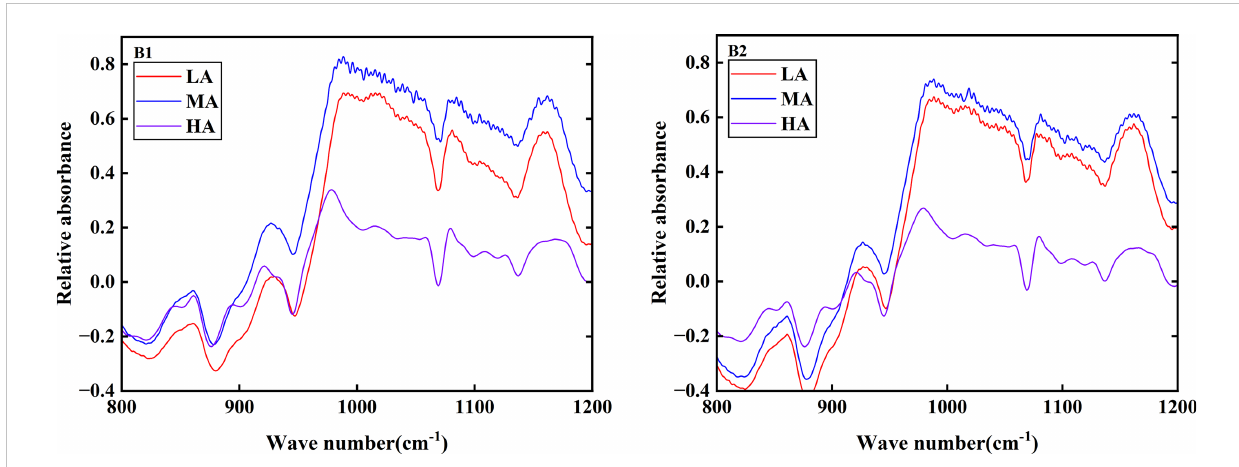
Figure 10 (DSC endothermic curve) of the thermal gelatinization characteristics of two potato starch varieties showed that in Xichang, the temperature span of Jiusen No.1 and Qingshu No.9 for gelatinization is longer, that is to say, the time required for the thermal gelatinization process is also longer. TABLE 5 Crystallinity and IR values of starch of two varieties at different altitudes. Altitude Variety Crystallinity(%) Jiusen No. 1